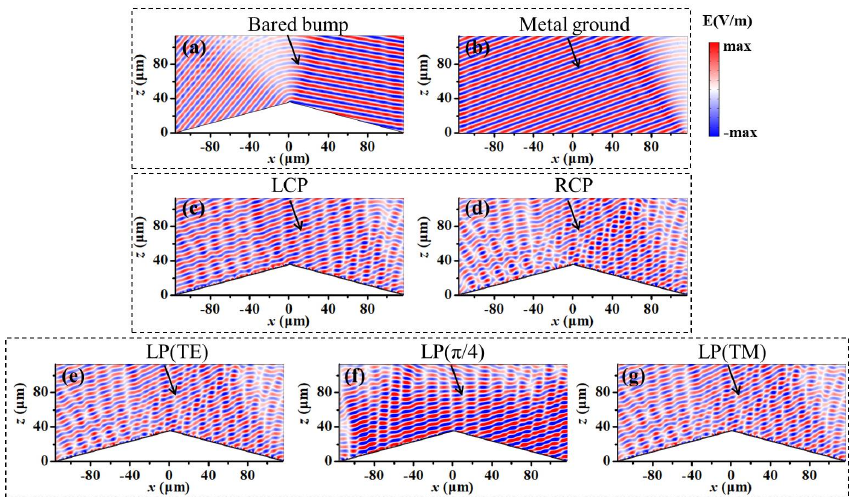
Figure 3. Cloaking response of our design upon arbitrary SOP under oblique incidence. For our design under the oblique incidence of 25°, the simulated reflected spatial distributions in the x – z plane for the bared bump under LCP incidence ( a ), metallic ground under LCP incidence ( b ) and the cloaked bump under LCP ( c ), RCP ( d ), LP (TE) ( e ), LP ( π /4) ( f ) and LP (TM) ( g ) illuminance, respectively.